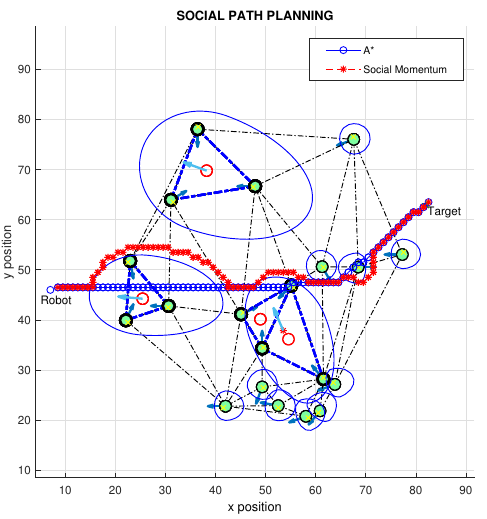
Figure 17. Proposed path planning method, different